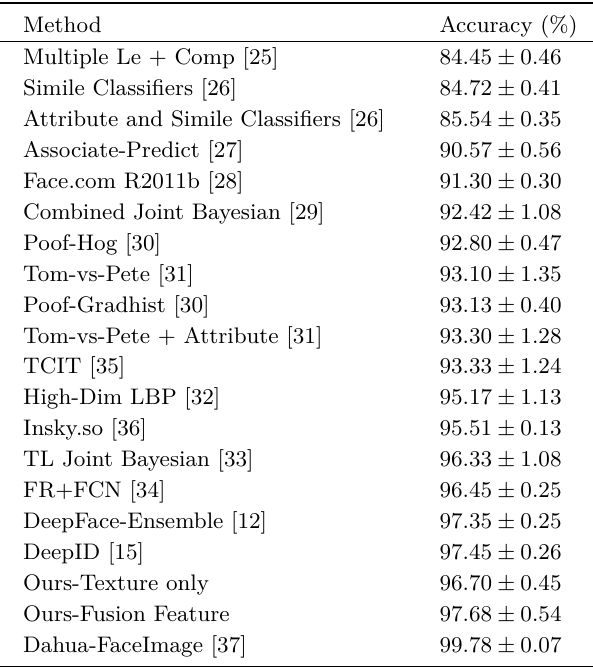
Table 4 Accuracy comparison with previous best methods using